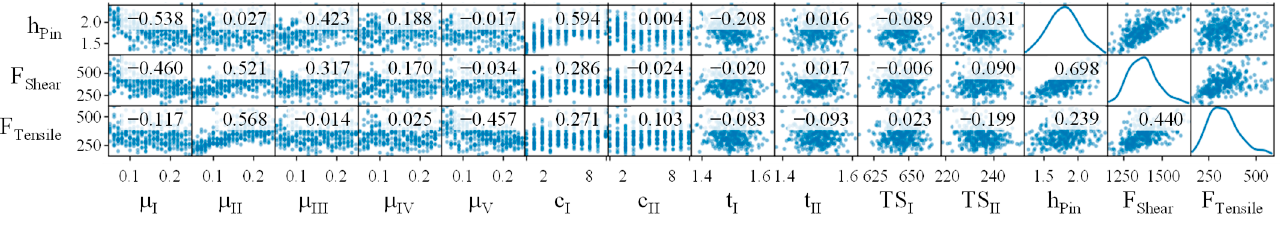
Figure 10. Pearson correlation coefficients showing the impact of varying input parameters on pin joint properties.